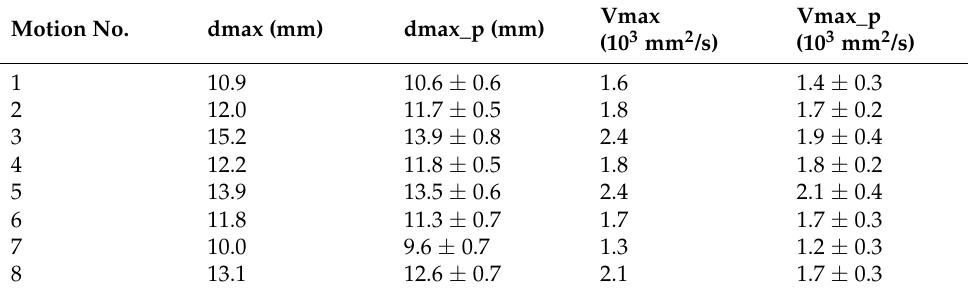
Table 10. Maximum opening distance and maximum-swept area velocity of aortic valves with eight motions (dmax: maximum opening distance of ground truth, dmax_p: maximum opening distance of prediction, Vmax: maximum-swept area velocity of ground truth, Vmax_p: maximum-swept area velocity of prediction) (mean ± std).